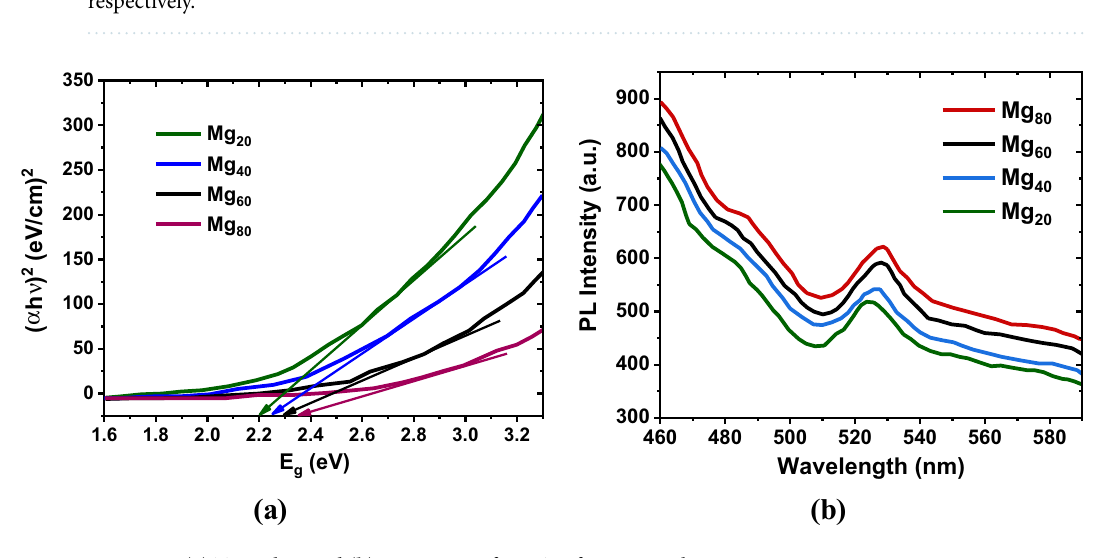
Figure 8. ( a ) Tauc plots and ( b ) PL spectra of Mg–Zn ferrite